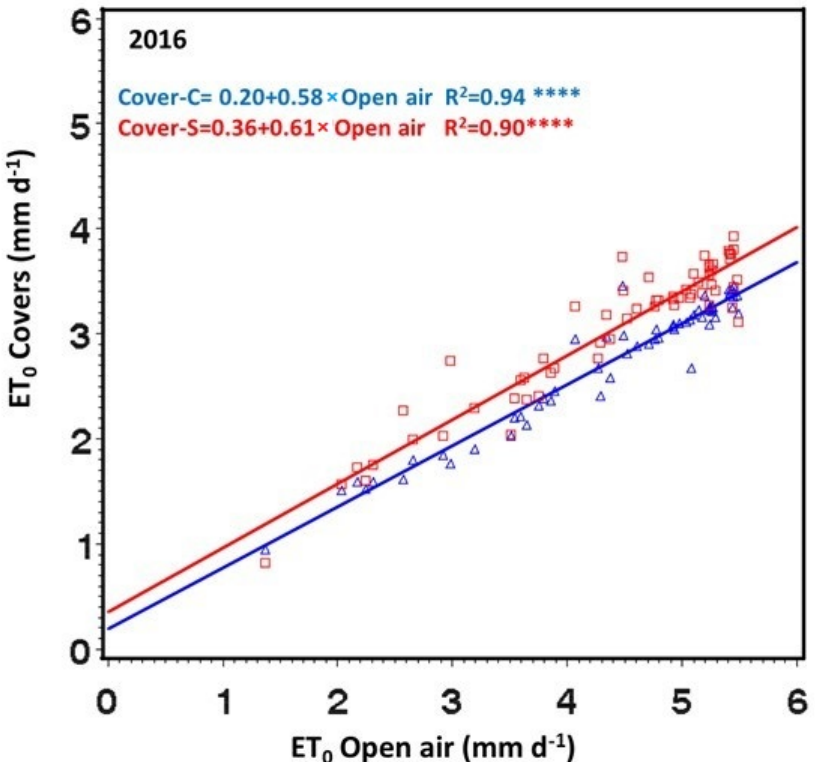
Figure 8. Linear regressions between daily reference evapotranspiration (ET 0 ) in open air and ET 0 under cover C (Coverlys ® agrotextile) or cover S (Serrosol film) in June and July of the second year of trial (**** indicates p <